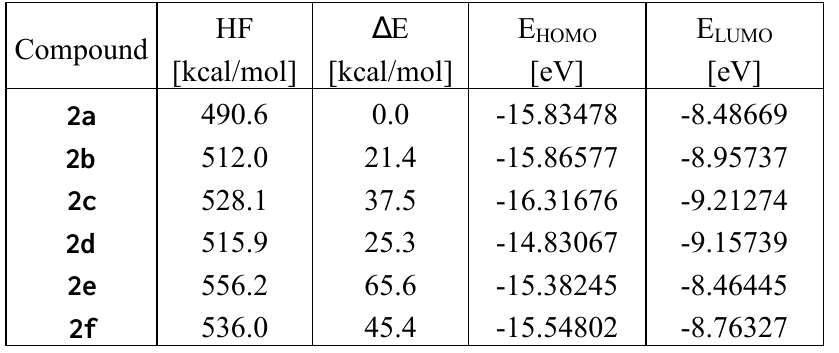
Table 1. Calculated AM1 energy data of isomers 2a-f